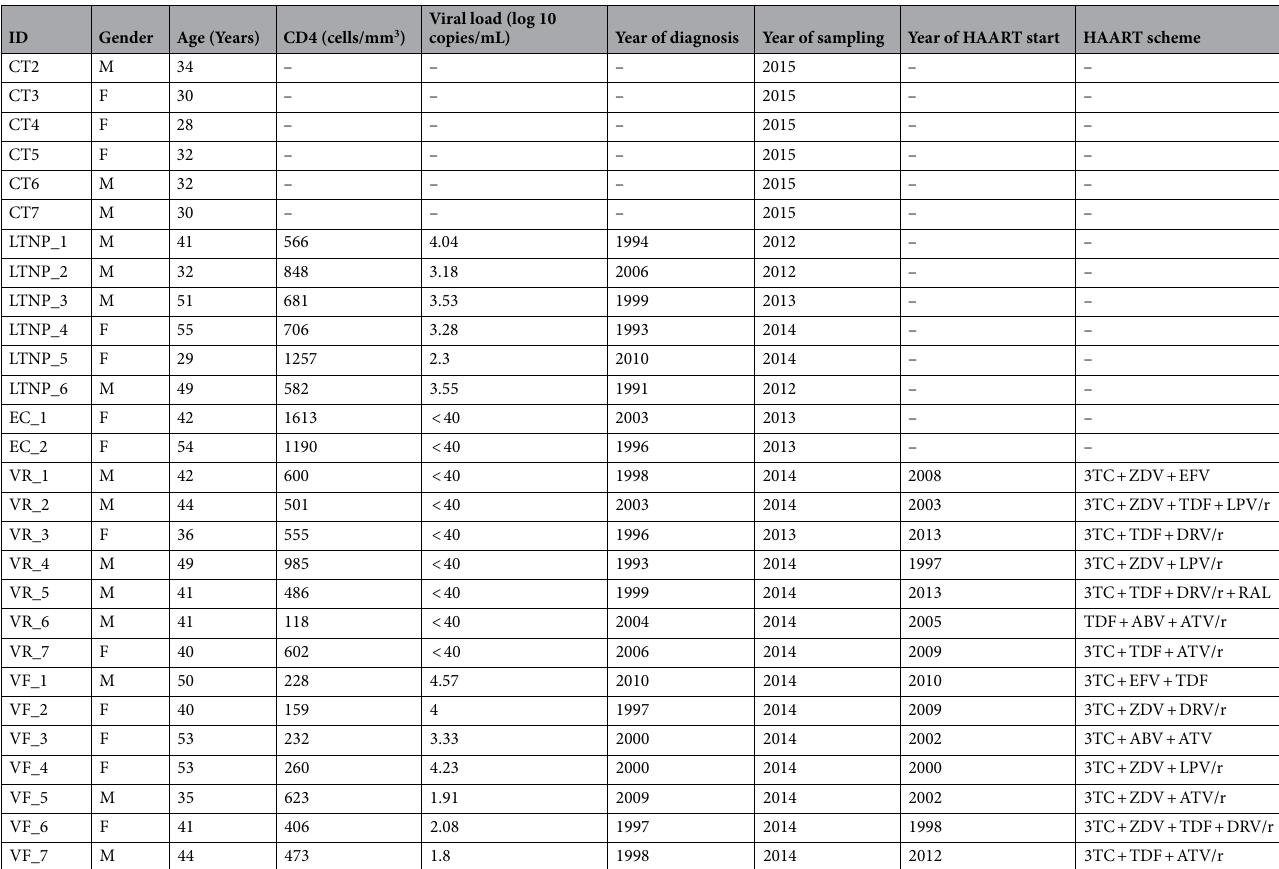
Table 1. Demographic, clinical and laboratory characteristics of the analyzed individuals. 3TC Lamivudine, ABV Abacavir, ATV Atazanavir, ATV/r Atazanavir + Ritonavir, CT Control, DRV Darunavir, DRV/r Darunavir + Ritonavir, EFV Efavirenz, E.C. Elite controller, F Female, HAART Highly active antiretroviral therapy, LPV/r Lopinavir + Ritonavir, LTNP Long-term non-progressor, M Male, RAL Raltegravir,